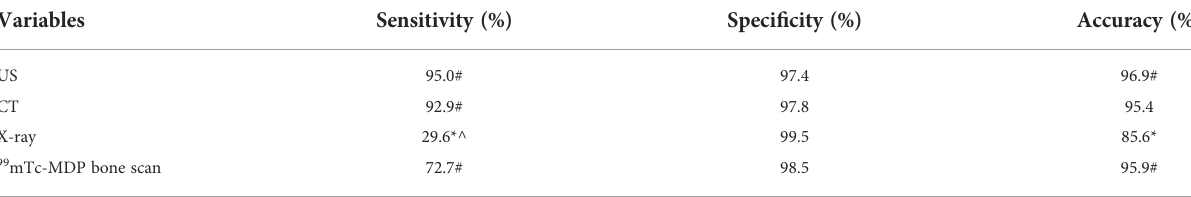
TABLE 1 Diagnostic value of different imaging methods in local recurrence after limb salvage, especially with metal implants in primary bone tumors. Variables